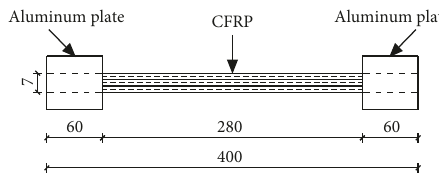
Figure 6: Dimensions of Table 2. For two-layer CFRP, the ultimate tensile stress and modulus of elasticity are 1141.52 MPa and 255.50 GPa, re- spectively. For three-layer CFRP, the ultimate tensile stress and modulus of elasticity are 952.57 MPa and 260.33 GPa, respectively. CFRP failed due to the fracture of CFRP fibers, as shown in Figure 8.